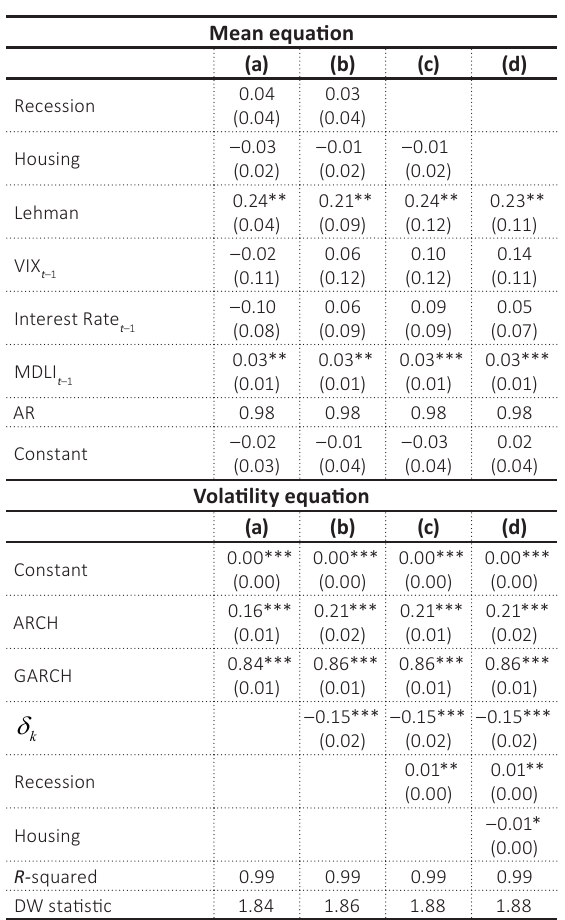
Table 4. Estimation